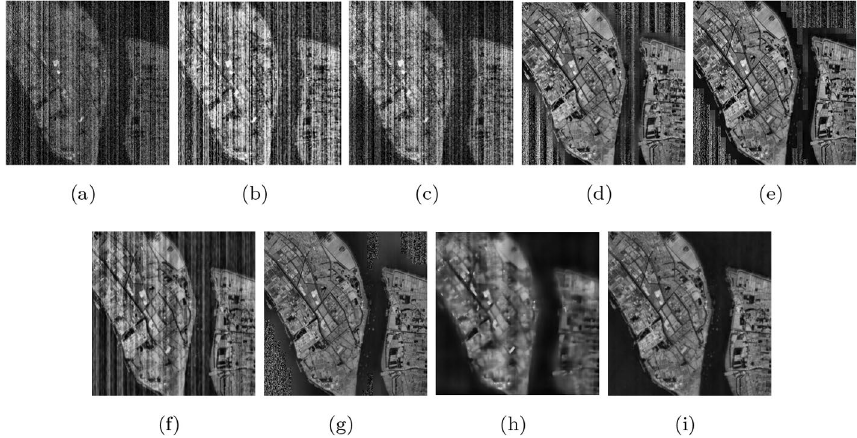
Fig. 7 Band 155 of the GF-5 Shanghai image before and after denoising via the different methods: a Original image; b BM4D; c LRMR; d NAILRMA; e LLRGTV; f MTGSNMF; g SSTVSSLR; h HSI-SDeCNN; i SRGLR